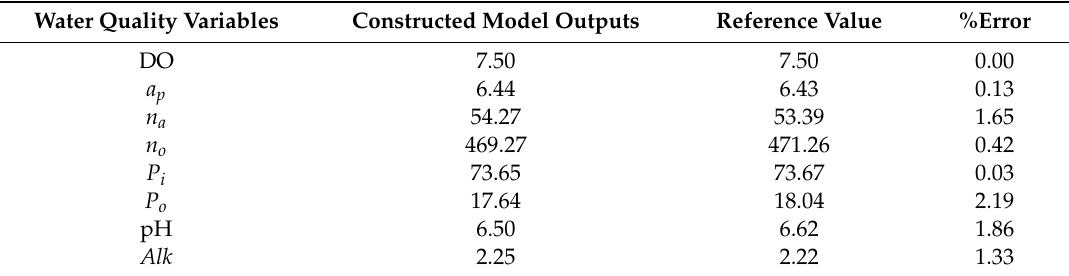
Table 4. Water quality variable validation